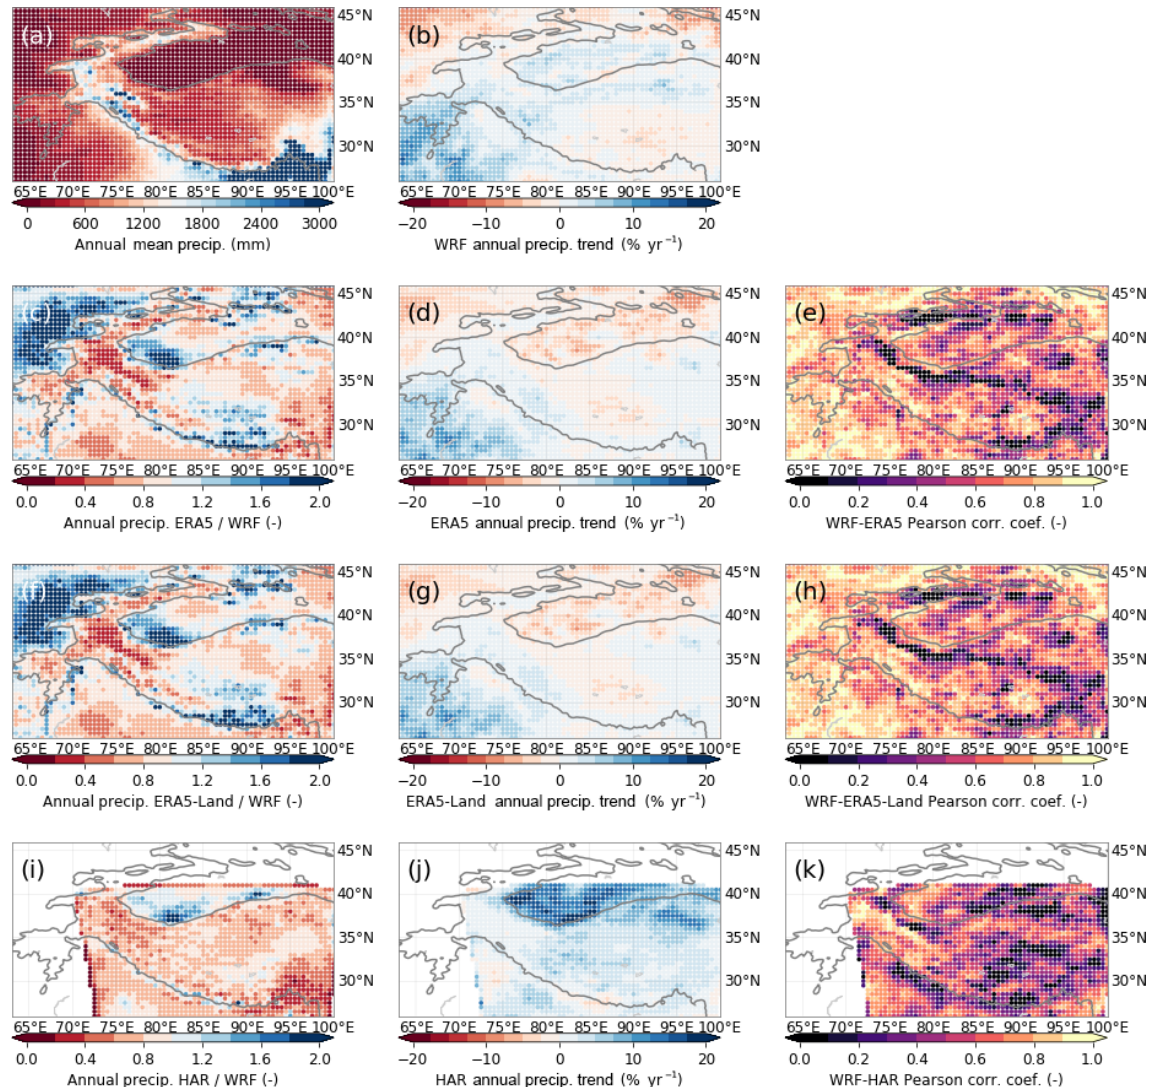
Figure 4. Comparison of WRF precipitation output (a–b) with three other datasets – ERA5 (c–e) , ERA5-Land (f–h) , and HAR (i–k) – between 2001 and 2010. Columns show precipitation multiplication factors (c, f, i) with respect to the annual mean precipitation (a) , annual precipitation trends (b, d, g, j) , and Pearson correlation coefficients between the datasets and our WRF results (e, h, k) . The 2000m elevation contour is indicated by a solid line.